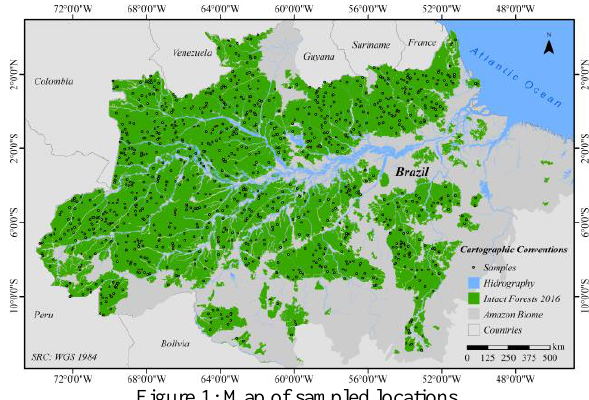
Figure 1: Map of sampled locations.